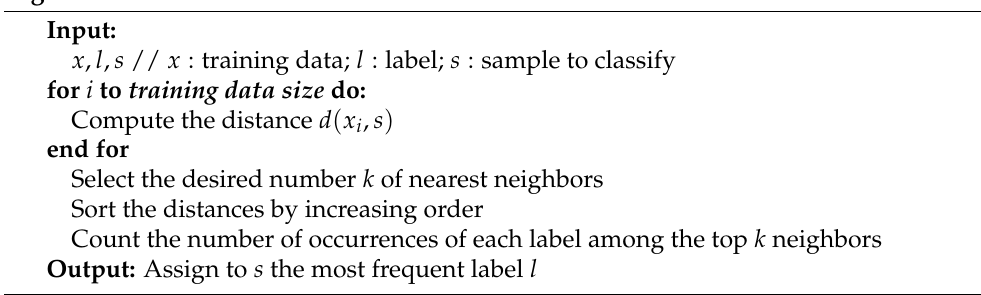
Figure 3. The distribution of dependent variables.